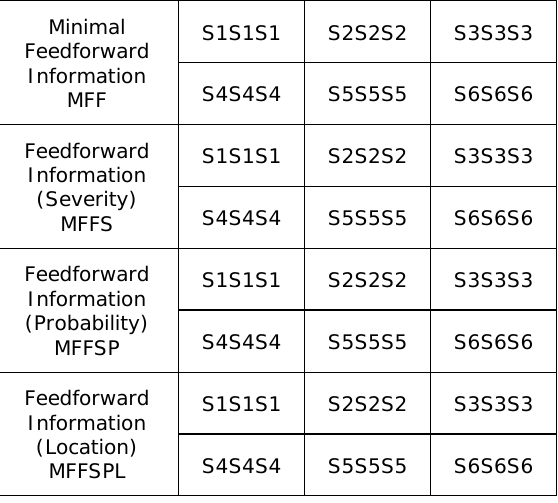
Table 3. Layout of Actual Study. Source: Own contribution.